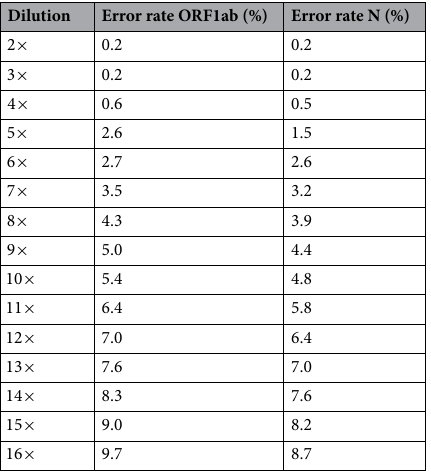
Table 3. Estimated upper bound for the error (false negative) rate for single pools of up to 16 samples for markers N and